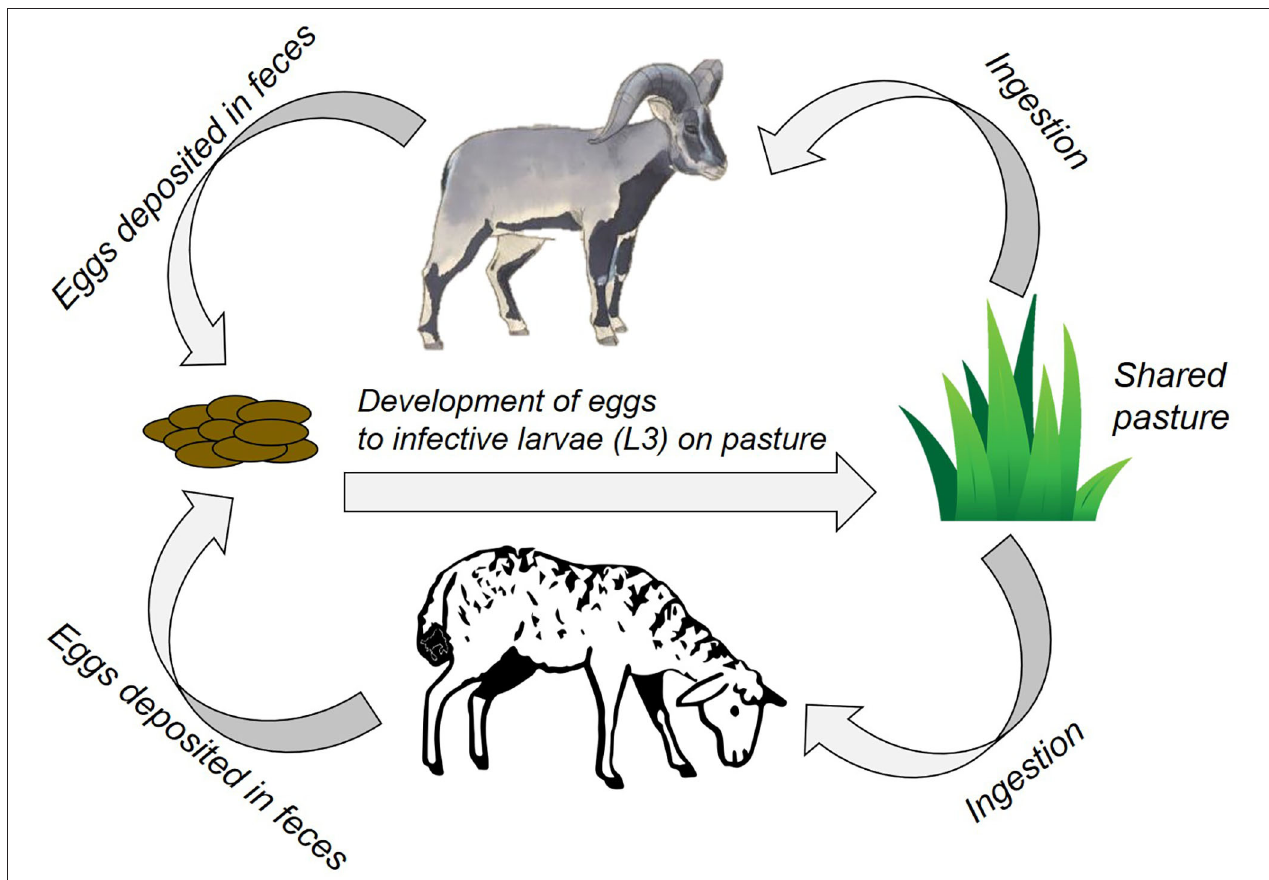
FIGURE 1 | A schematic for GIN transmission in our case study site. Above: Bharal, Below: Livestock (sheep/goat). Sheep icon courtesy Francesco Cesqo Stefanini (noun project) and bharal courtesy Sartaj